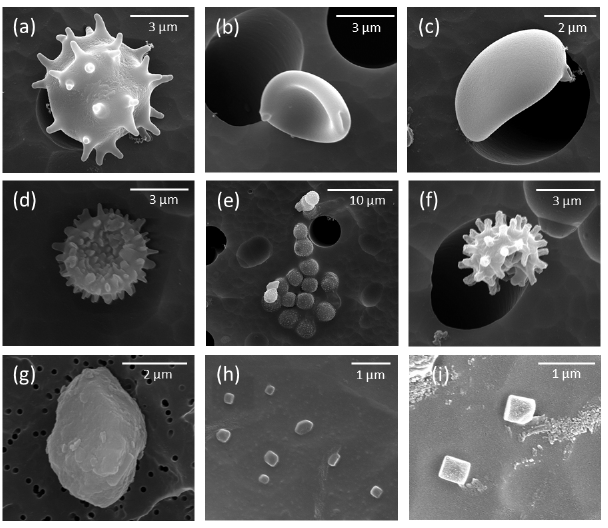
Figure 11. Scanning electron microscope images of the exemplary aerosol particles (FBAP and TAP) observed during the campaign at Munnar. The scale bar is shown at the top right corner of each image.